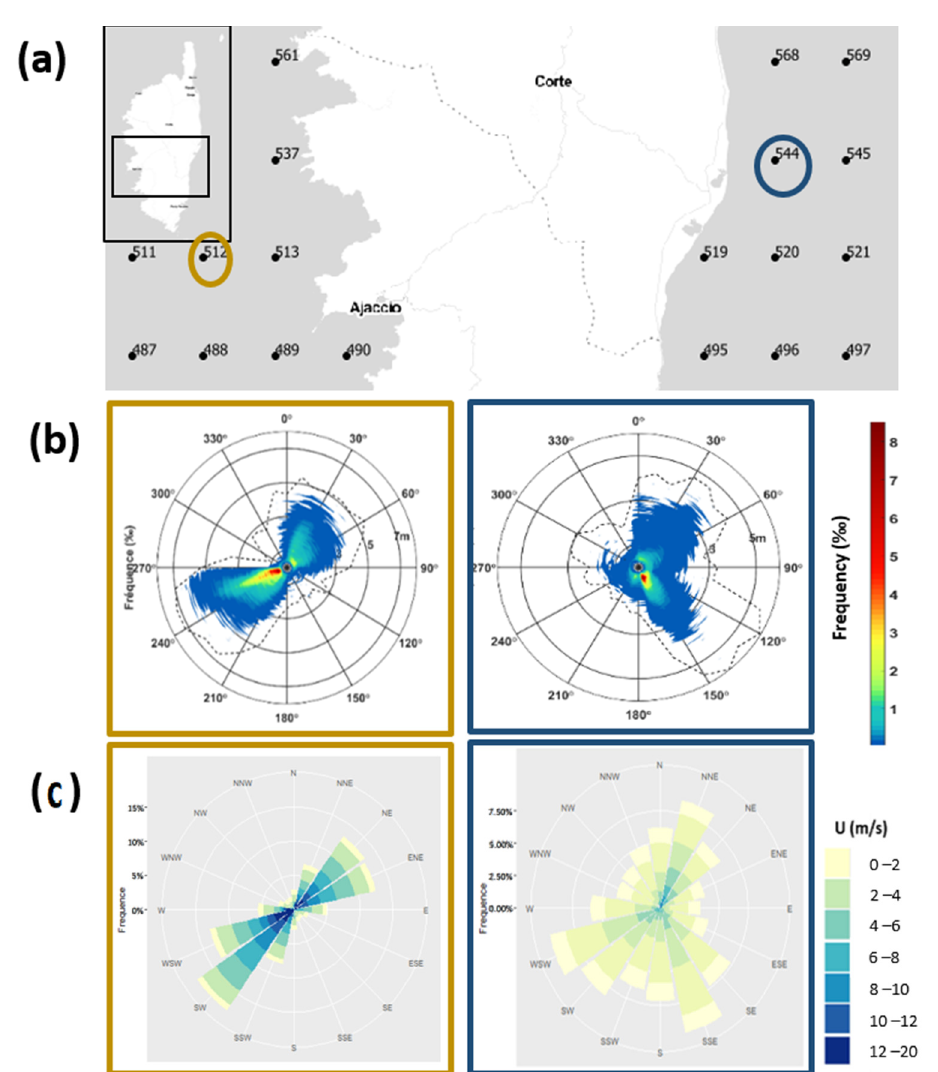
Figure 7. ( a ): Location of points NWW3 512 and NWW3 544 along Corsica. ( b ) Wave roses at point NWW3 512 (left) and NWW3 544 (right) giving the dominant peak direction (Dp) (°) and Hs frequency (‰). The black dashed lines represent the contour of extreme Hs. ( c ) Wind roses at point NWW3 512 (left) and NWW3 544 (right) giving the dominant wind direction Du (°), and U (m/s).